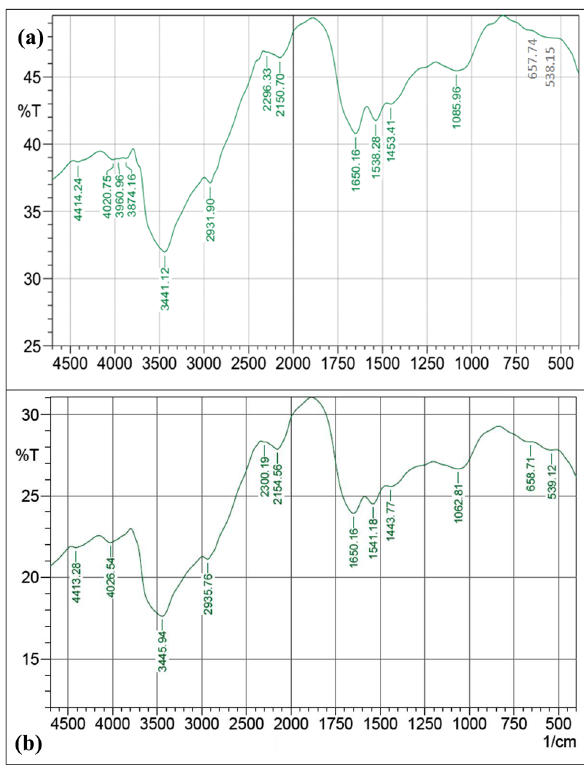
Figure 5: FTIR spectra of Gelidium amansii biomass: ( a ) before Ni 2 +